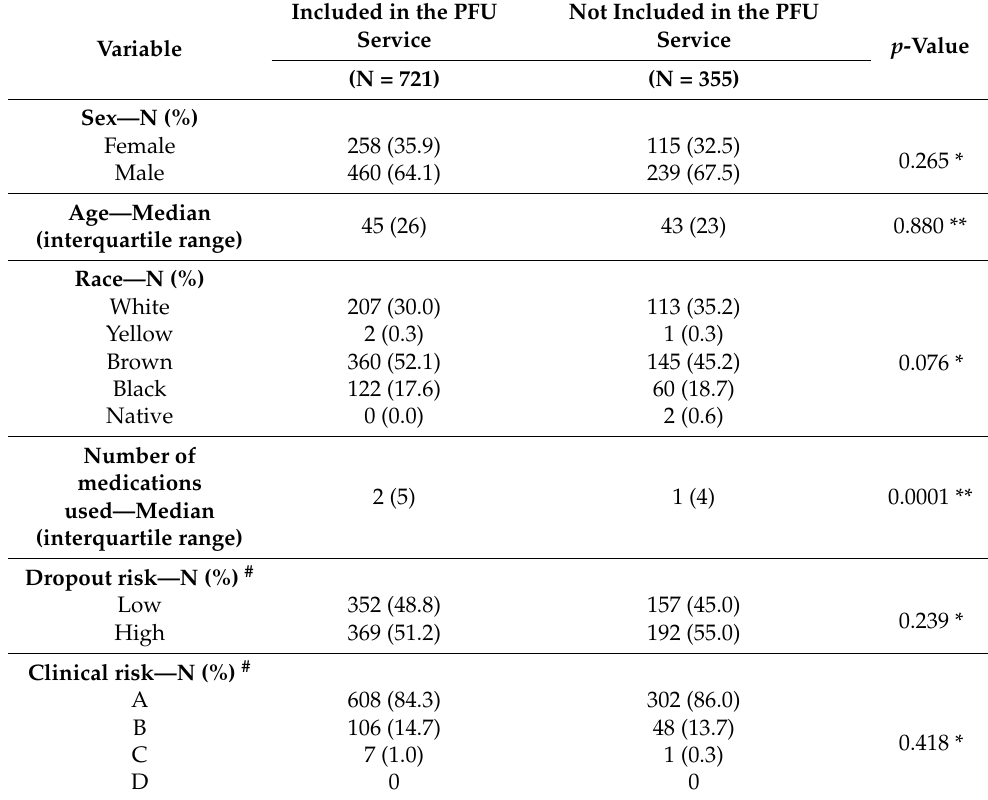
Table 1. Characteristics of patients undergoing tuberculosis treatment in primary healthcare centers, included or not included in the pharmacotherapeutic follow-up (PFU) service of 2018–2020. Belo Horizonte-MG.